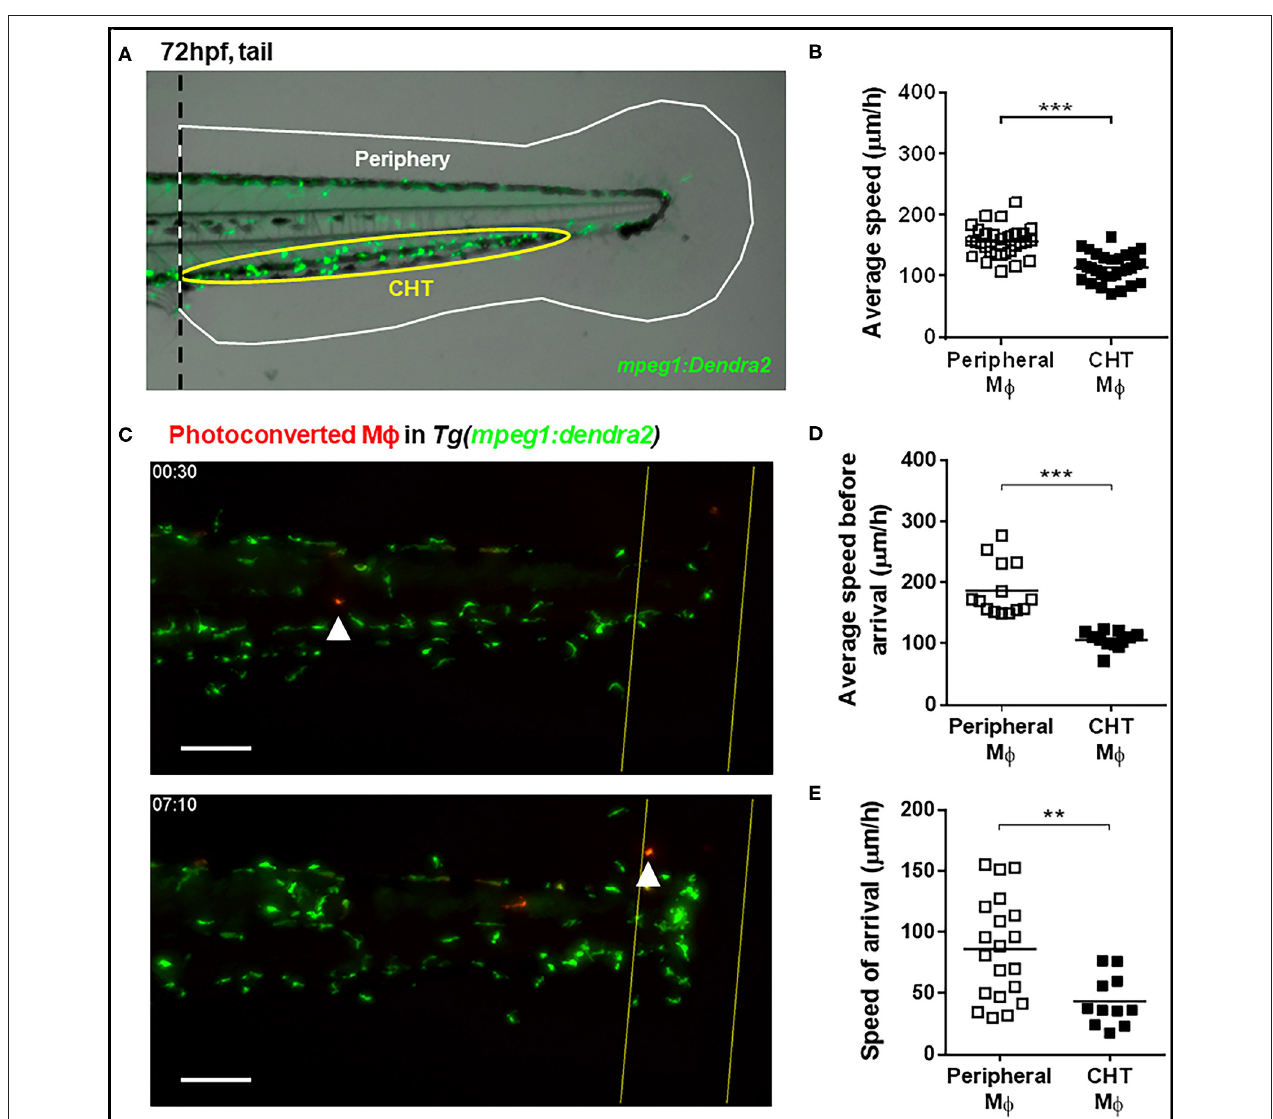
FIGURE 1 | Kinetic differences between peripheral tissue-resident and CHT-resident macrophages in steady state and after damage. (A) At 72 hpf, macrophages in the Tg(mpeg1:Dendra2) reporter line were classified as peripheral tissue-resident macrophages (white area) or CHT-resident macrophages (yellow area). (B) Average speed of peripheral and CHT macrophages (M φ ) in steady state conditions. A tail portion of Tg(mpeg1:Dendra2) larva was imaged every 3min for 3h. (C) Time lapse imaging of photoconverted macrophages recruited to the damaged site in Tg(mpeg1:Dendra2) larvae. The photoconversion was performed before damage, and the complete tail region was captured every 5min for a total of 24h. Representative images showing a peripheral macrophage (white arrowhead) in the start of the time lapse (upper image), and at the time of recruitment to the damage site (lower image). Scale bar = 50 µ m. (D) The average speed and (E) the speed of arrival of individual photoconverted macrophages. A total of 14 peripheral macrophages and 12 CHT macrophages from a pool of photoconverted individuals were used for the analysis. ** p < 0.01; *** p <